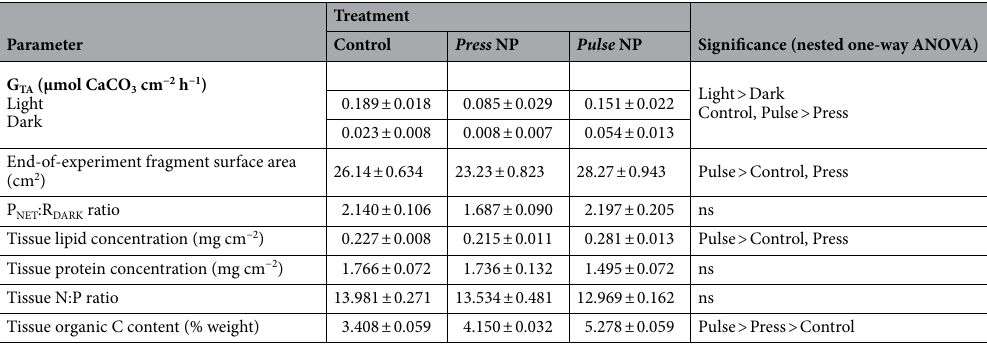
Table 1. Physiological parameters (mean ± SE) measured for fragments of Acropora intermedia after 7-week exposure to continuously ( Press ) and temporary ( Pulse ) elevated ammonium (N) and phosphate (P) concentrations, as well as under ambient (Control)